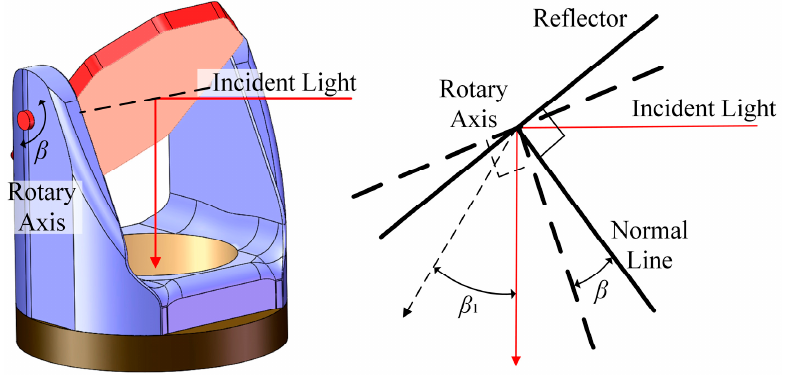
When the multi-address transceivers were mounted with the reflectors without 2:1 transmissions, doubled optical coupling effect appeared in the rotation of the pitch axis, as illustrated in Figure 6.